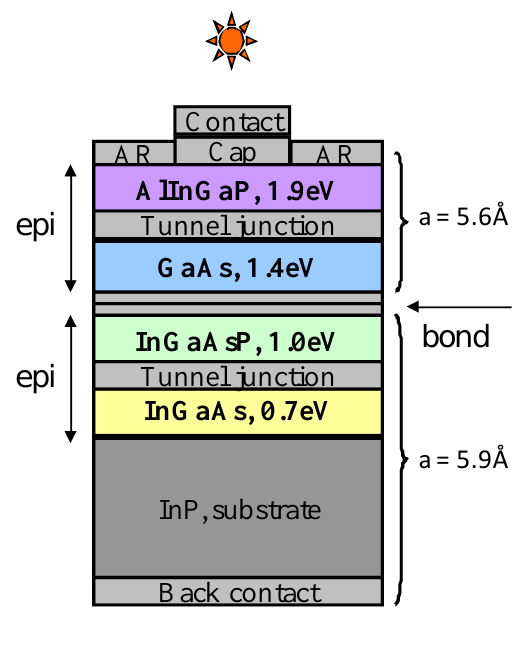
Figure 11. Cross-sectional schematic of a direct-bonded monolithic lattice-mismatched four-junction solar